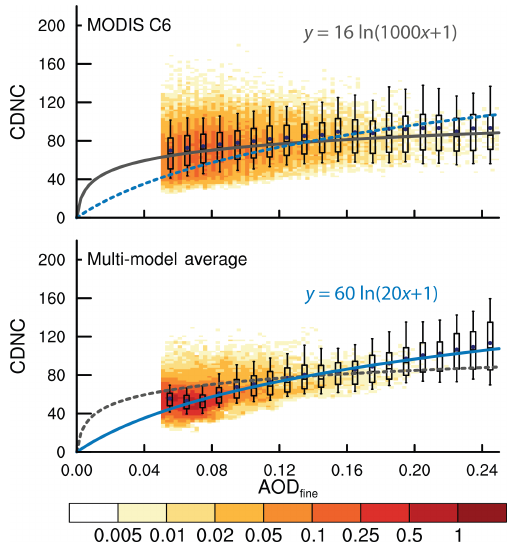
Figure 8. Fine-mode aerosol optical depth and cloud-droplet popu- lation density joint histograms based on monthly (1 × 1 ◦ ) averaged data. Histograms are based on retrievals from MODIS collection 6 (upper) and AeroCom Phase I models. The derived relationship is presented in the upper-right section of each panel based on a fit along the highest frequency of 20 AOD section bins. The data in each AOD bin are summarized by boxes which indicate the 25th and 75th percentiles. The whiskers outside each box indicate the 10th and 90th percentiles; the horizontal line and the dot in each box indicate the median and average, respectively. The solid line denotes the fit to the data in the plot, and the dashed the data in the other